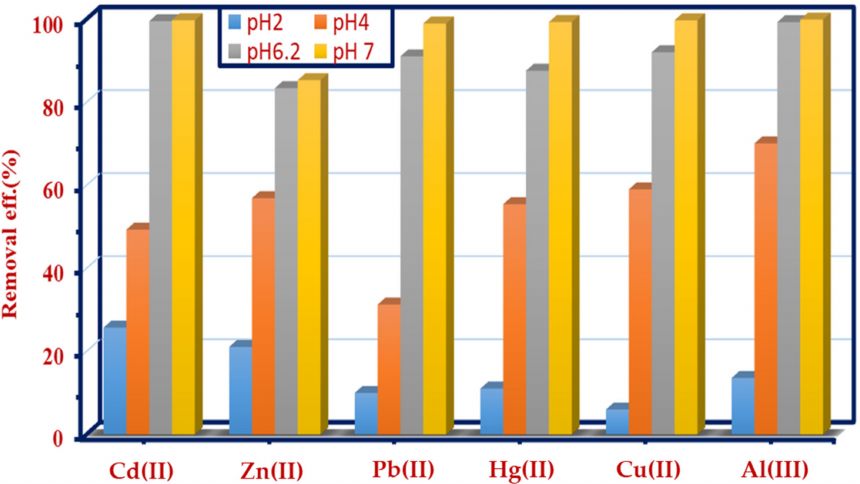
Figure 10. Removal efficiency % for MCH-ATA after treatment of contaminated ground water at different pH